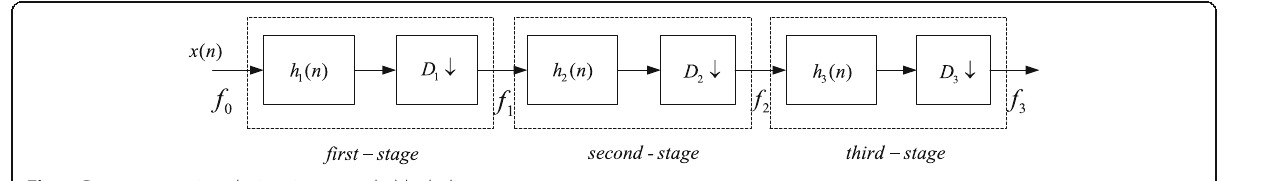
Fig. 1 Down-conversion decimation cascade block diagram